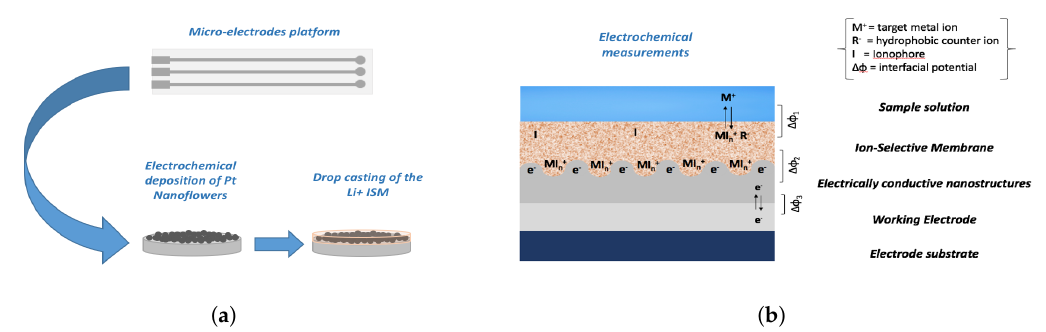
Figure 2. ( a ) A schematic illustration of the fabrication of the Li + ion-selective sensors (ISE) based on the one-step electrodeposition of platinum nanostructures on micro-electrodes. The working mechanism is highlighted in ( b